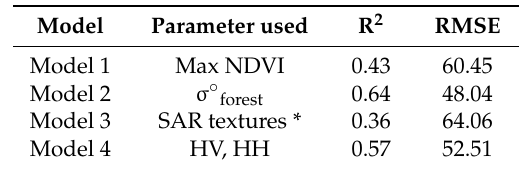
Table 6. Summary of the single-sensor-based estimates of the biomass in terms of coefficient of determination (R 2 ) and root mean square error (RMSE).